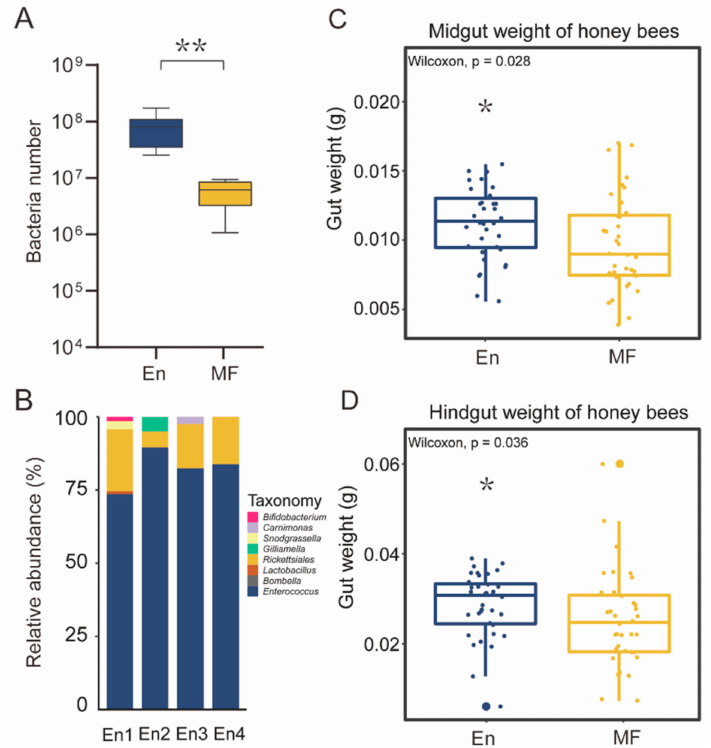
Figure 4. Gut weight in E. faecium H7 colonized honey bees. Total bacteria number (En: n = 6; MF: n = 6) ( A ) and gut microbiota composition (n = 4) ( B ) after E. faecium H7 colonized for 7 days. The weight of midgut ( C ) and hindgut ( D ) increased in En bees (En: n = 36; MF: n = 36). * p < 0.05, ** p < 0.01. En: E. faecium H7 colonized; MF: